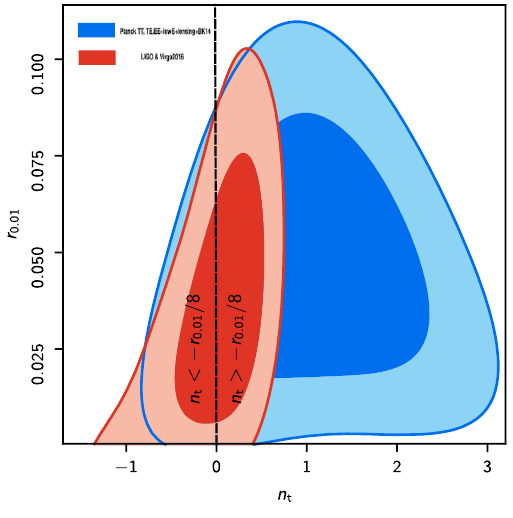
Figure 5 . In the above plot, we note that the predictions of non-local R 2 -like in(cid:13)ation can be anywhere within the likelihood projected ( n t ; r ) plane of latest Planck 2018